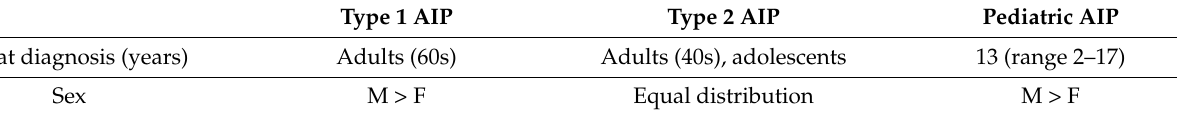
Table 3. Differential diagnosis of Type 1 and Type 2 AIP (adapted from